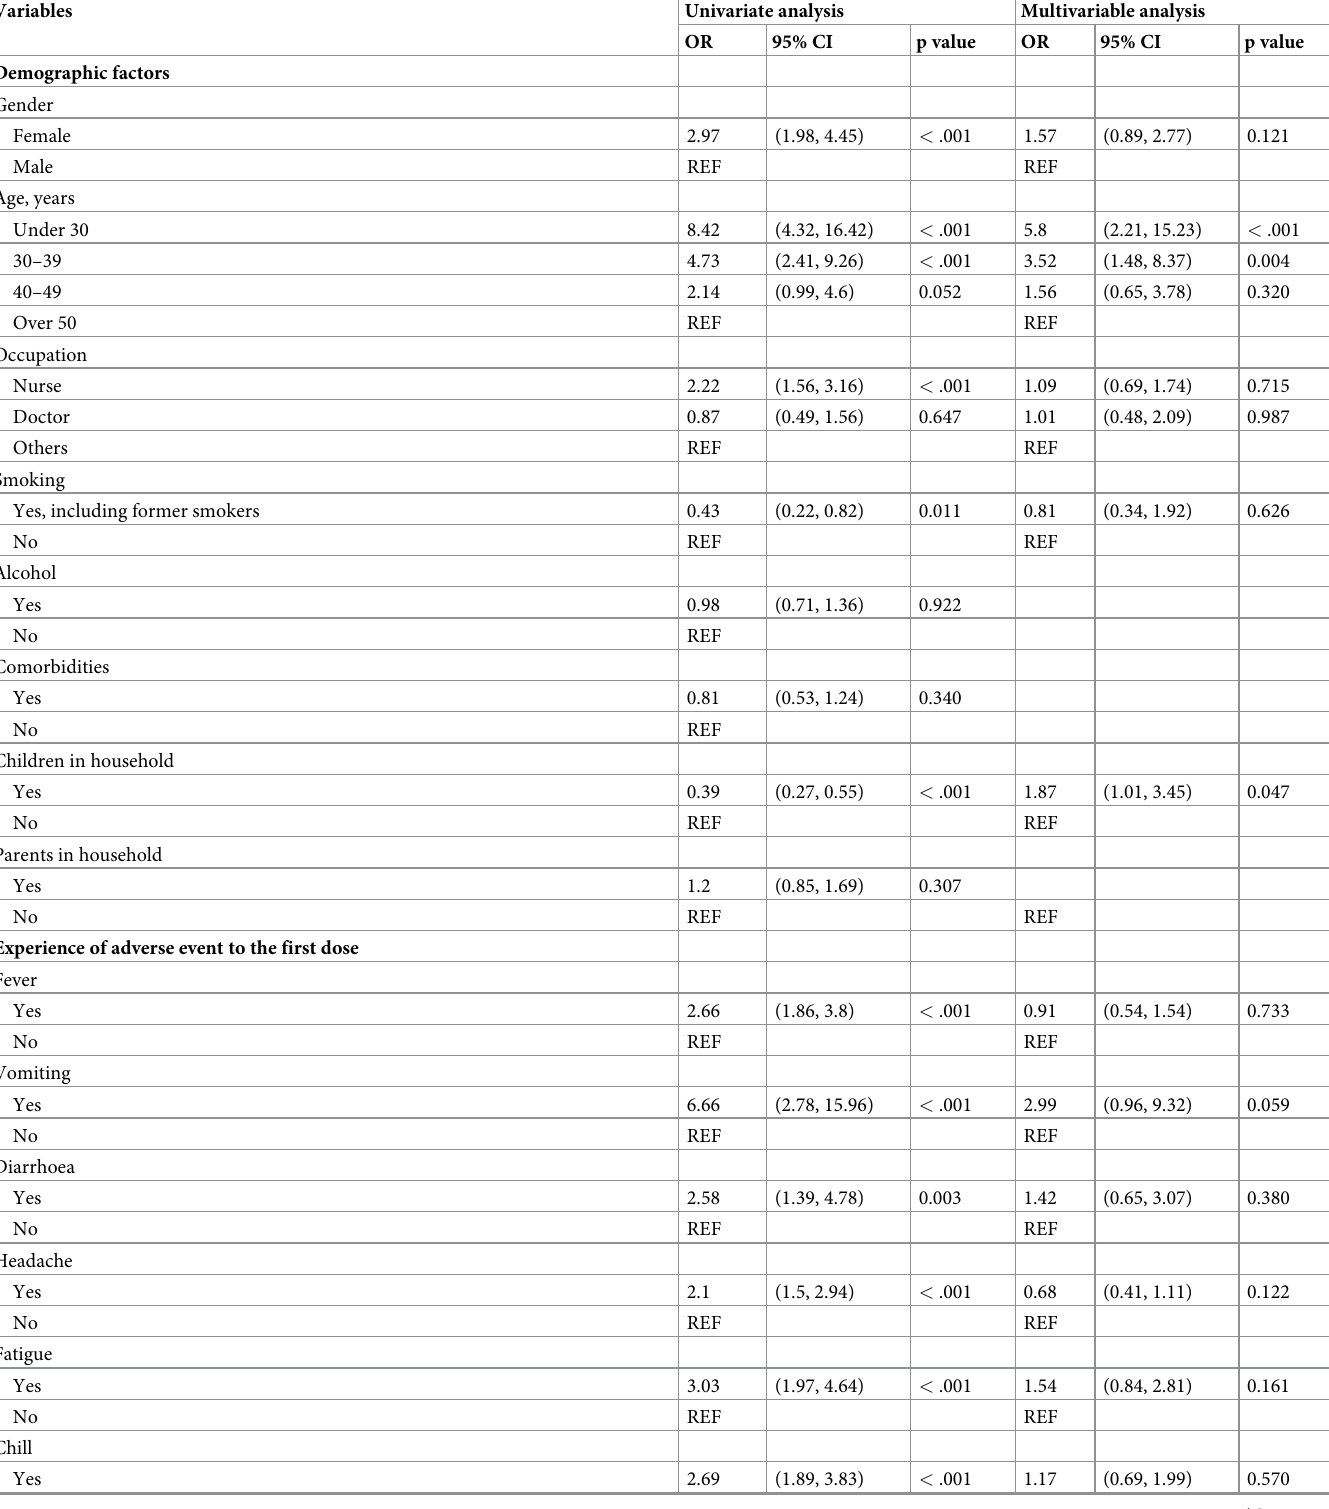
Table 2. Factors associated with hesitancy to the second dose of ChAdOx1 nCov-19 vaccine ( N =